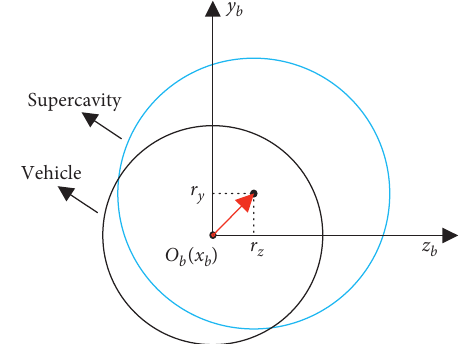
Figure 2: Relationship between vehicle and cavity at stern plane (back